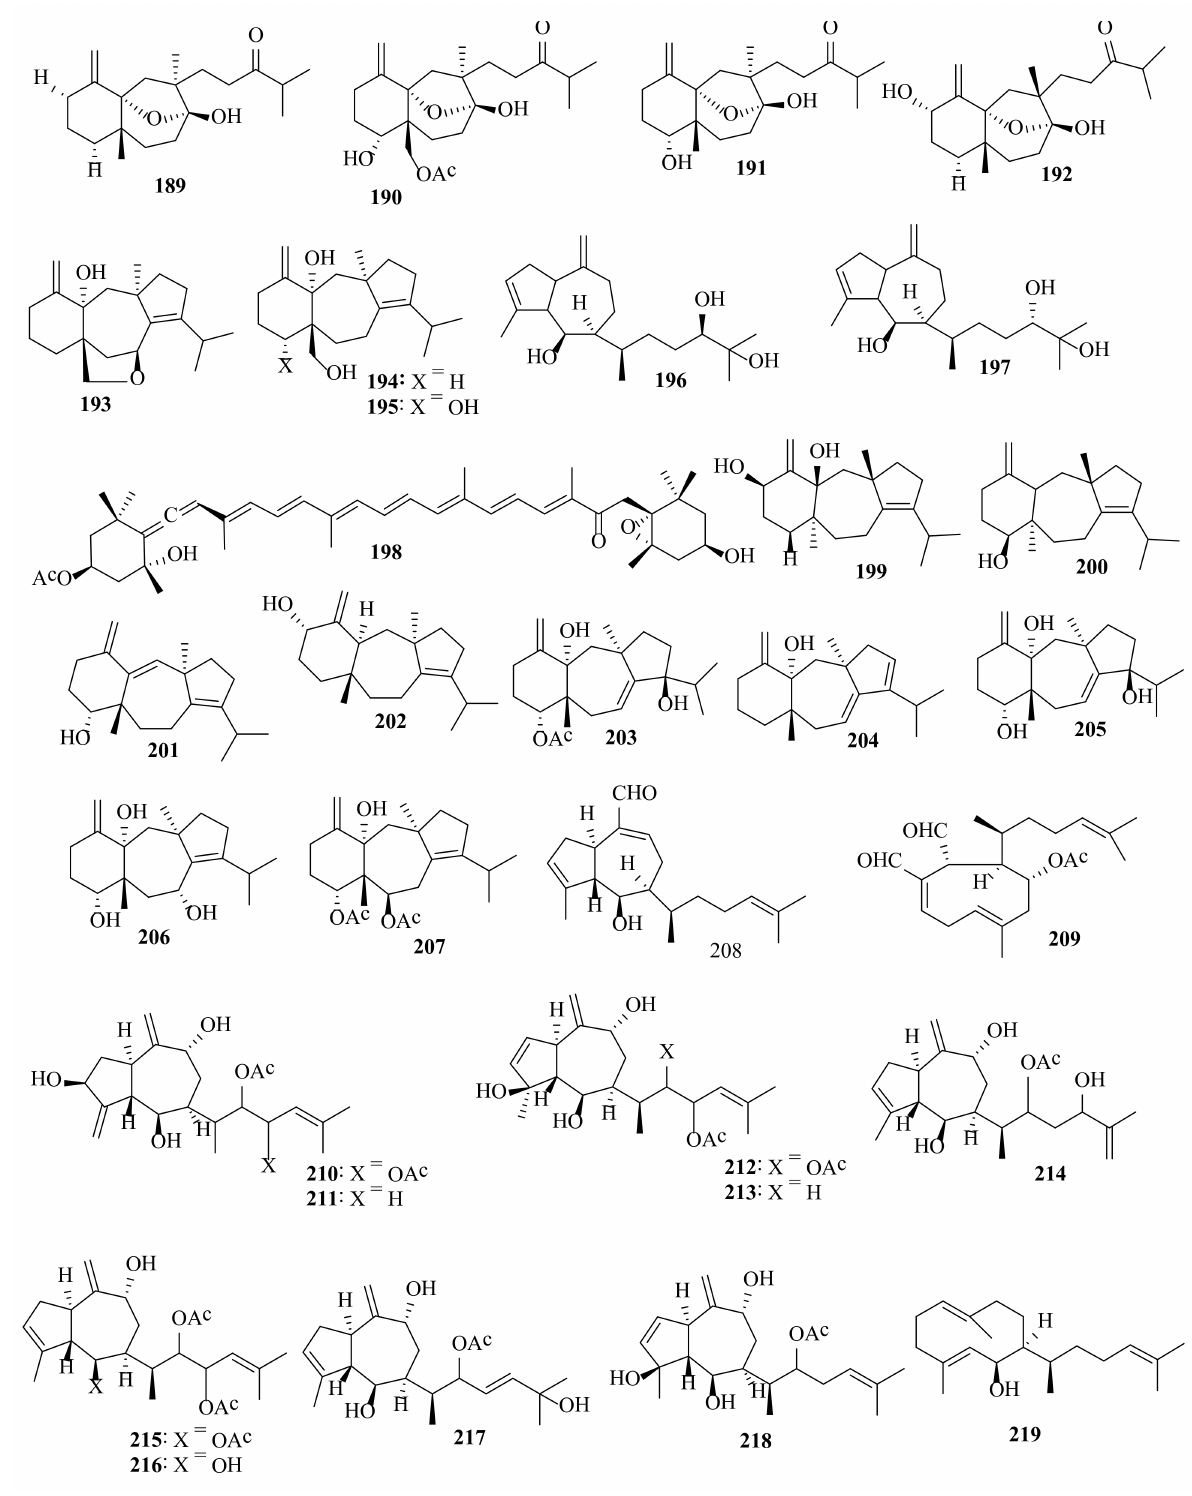
Figure 8. Chemical structures of compounds 189 – 219 . Diterpenes 189 – 197 and carotenoid 198 were isolated from D. dichotoma var. indica , diterpenes 199 – 209 were isolated from D. dichotoma var. linearis , and diterpenes 210 – 219 were isolated from D. dichotoma var. volubilis . The configuration of all stereocenters in each compound is shown as given in the literature. Dictinol ( 193 ), dictindiol ( 194 ), and dictintriol ( 195 ) (Figure 8) are dolastane diter- penoids that have been isolated from the acetone extract of D . dichotoma var. indica.